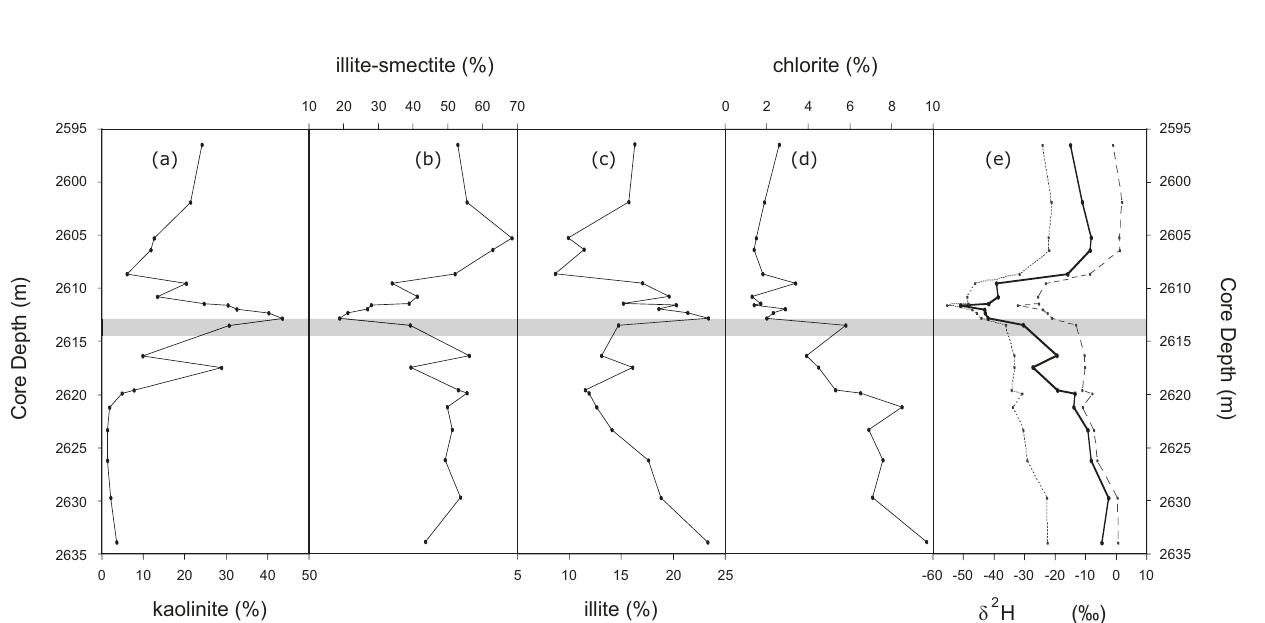
hydroxyl δ 2 H OH VSMOW(ViennaStandardMeanOceanWater); c percentageofthe dino fl agellate Apectodinium spp. (several species) 10 ; d percentage of low-salinity dino fl agellatecystsexcluding Apectodinium 10 ; e clayhydroxyl δ 18 O OH ;and f thebulk clay δ 18 O bulk . Error bars for b , e and f are ±1 σ analytical uncertainty (Methods).